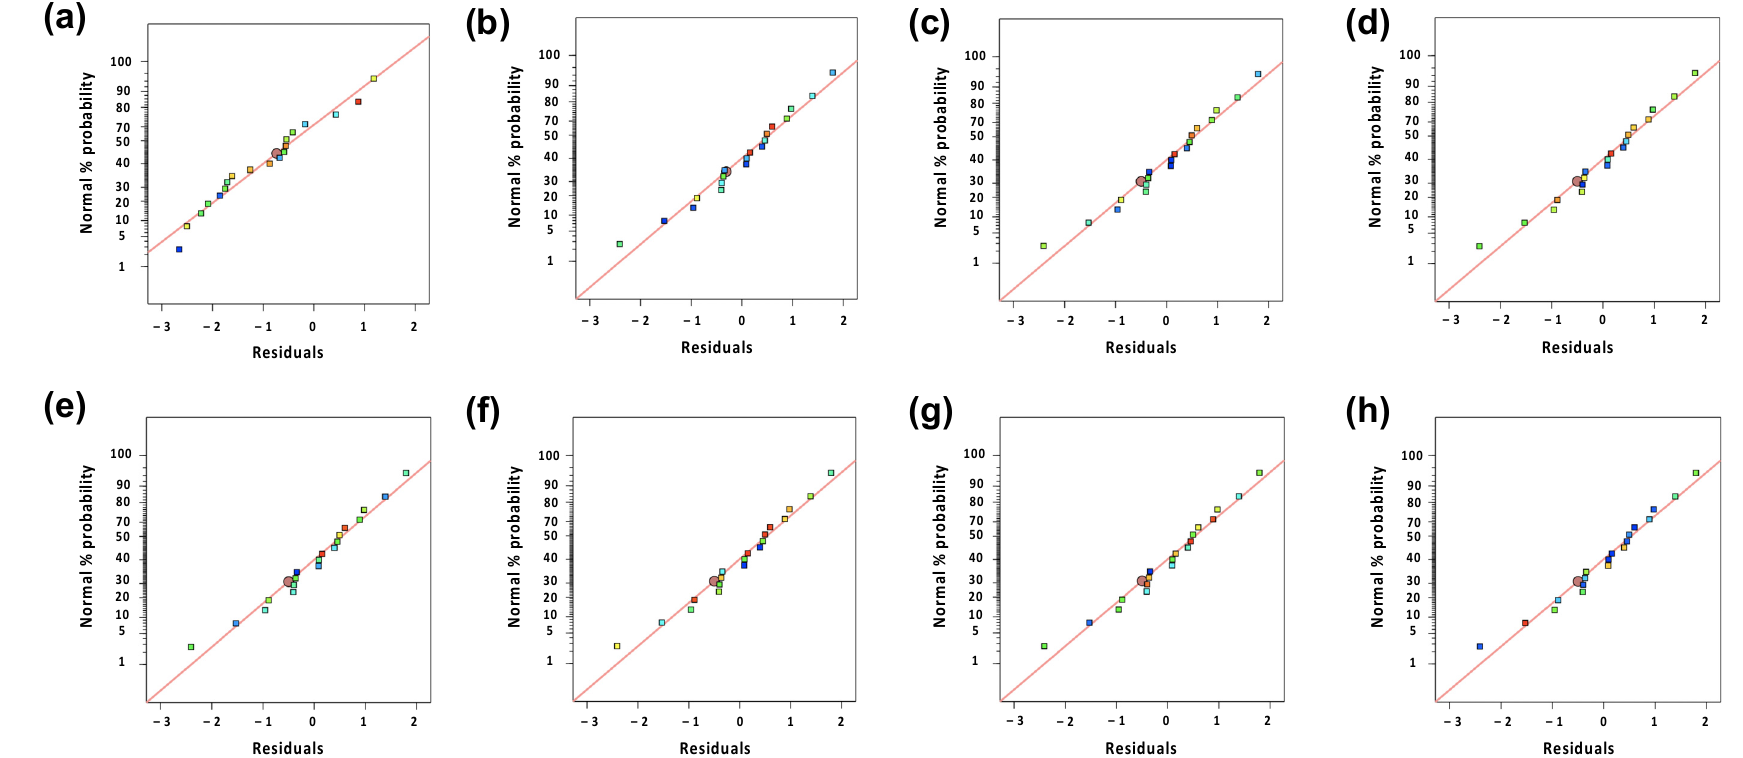
Figure 3. Residual plots. ( a ) Y 1 : GA % dissolved at 2 h; ( b ) Y 2 : GA % dissolved at 6 h; ( c ) Y 3 : GA % dissolved at 12 h; ( d ) Y 4 : BMUL % dissolved at 2 h; ( e ) Y 5 : BMUL % dissolved at 6 h; ( f ) Y 6 : BMUL % dissolved at 12 h; ( g ) Y 7 : hardness; ( h ) Y8: friability.